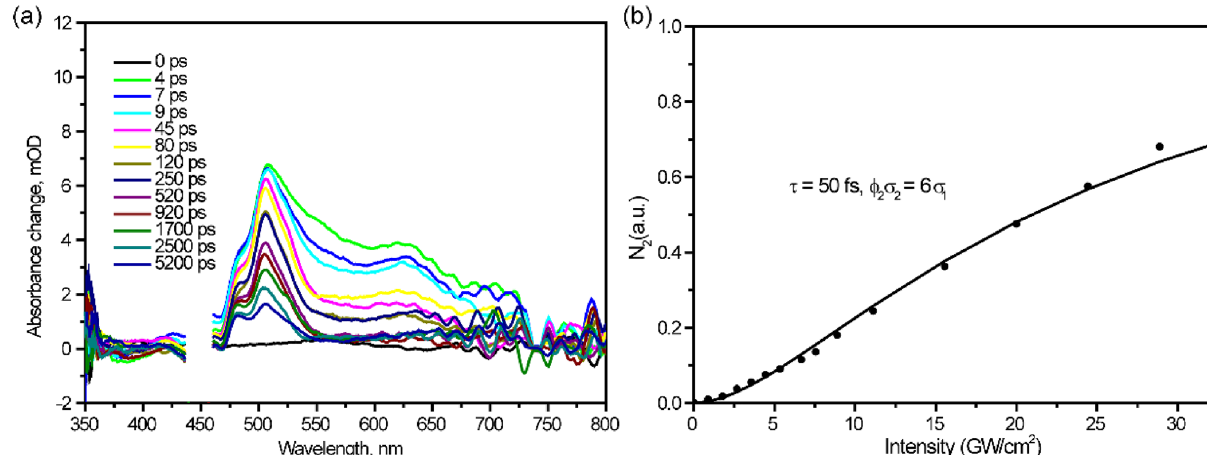
Figure 6. (a) fsTA spectra of perylene film atλ ex = 450 nm. (b) Intensity dependence of the 480 nm transient (TT absorption) versus the laser excitation